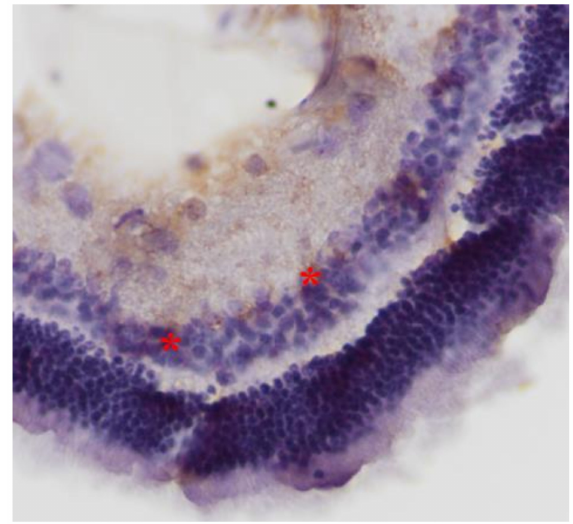
Figure 7. Group V. Mild intensity ( + ) of immunohistochemical staining. Presence of lymphocytes (*). IL-6. ×